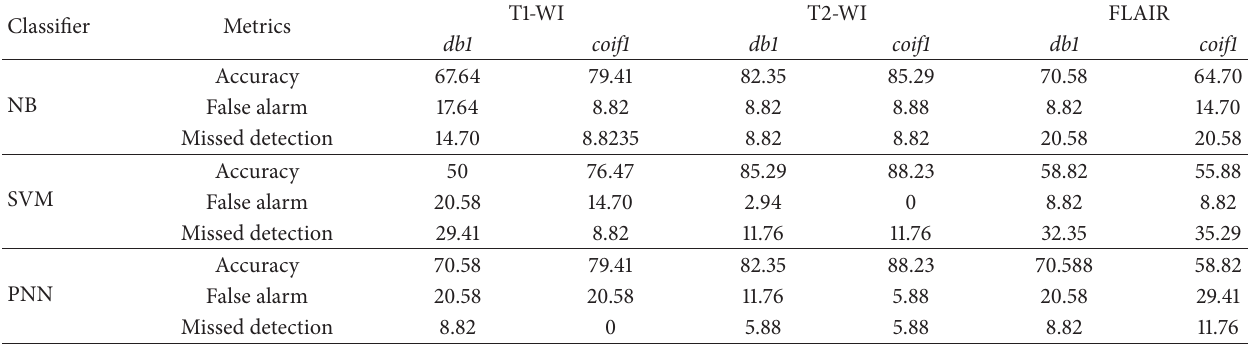
Table 3: Performance metrics (%) based on the wavelets.